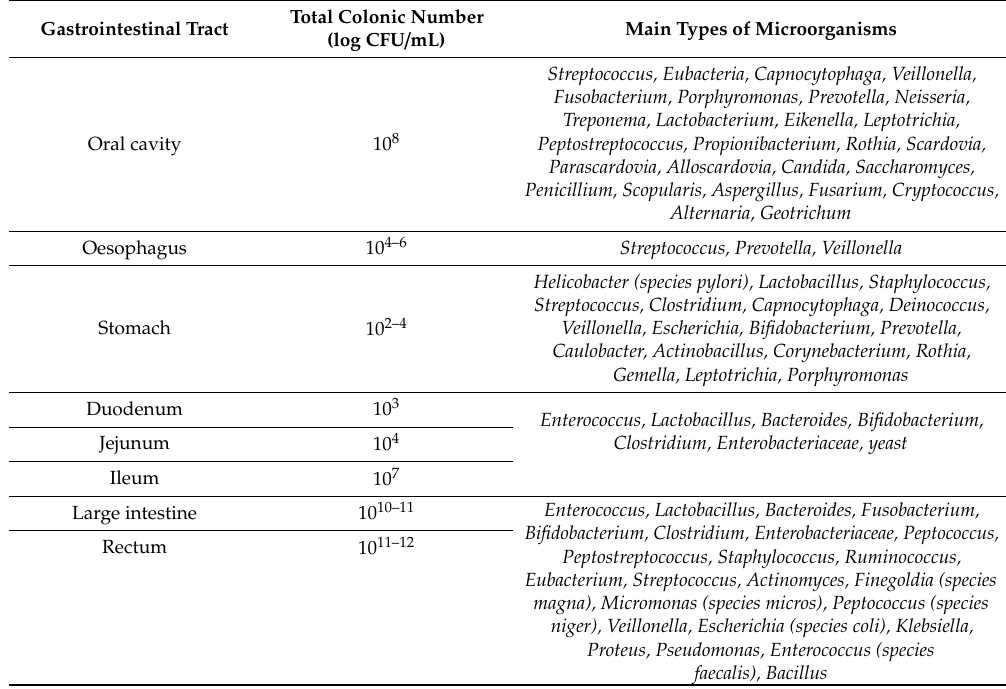
Table 1. The amount and types of microorganisms in the gastrointestinal tract (GIT) of human